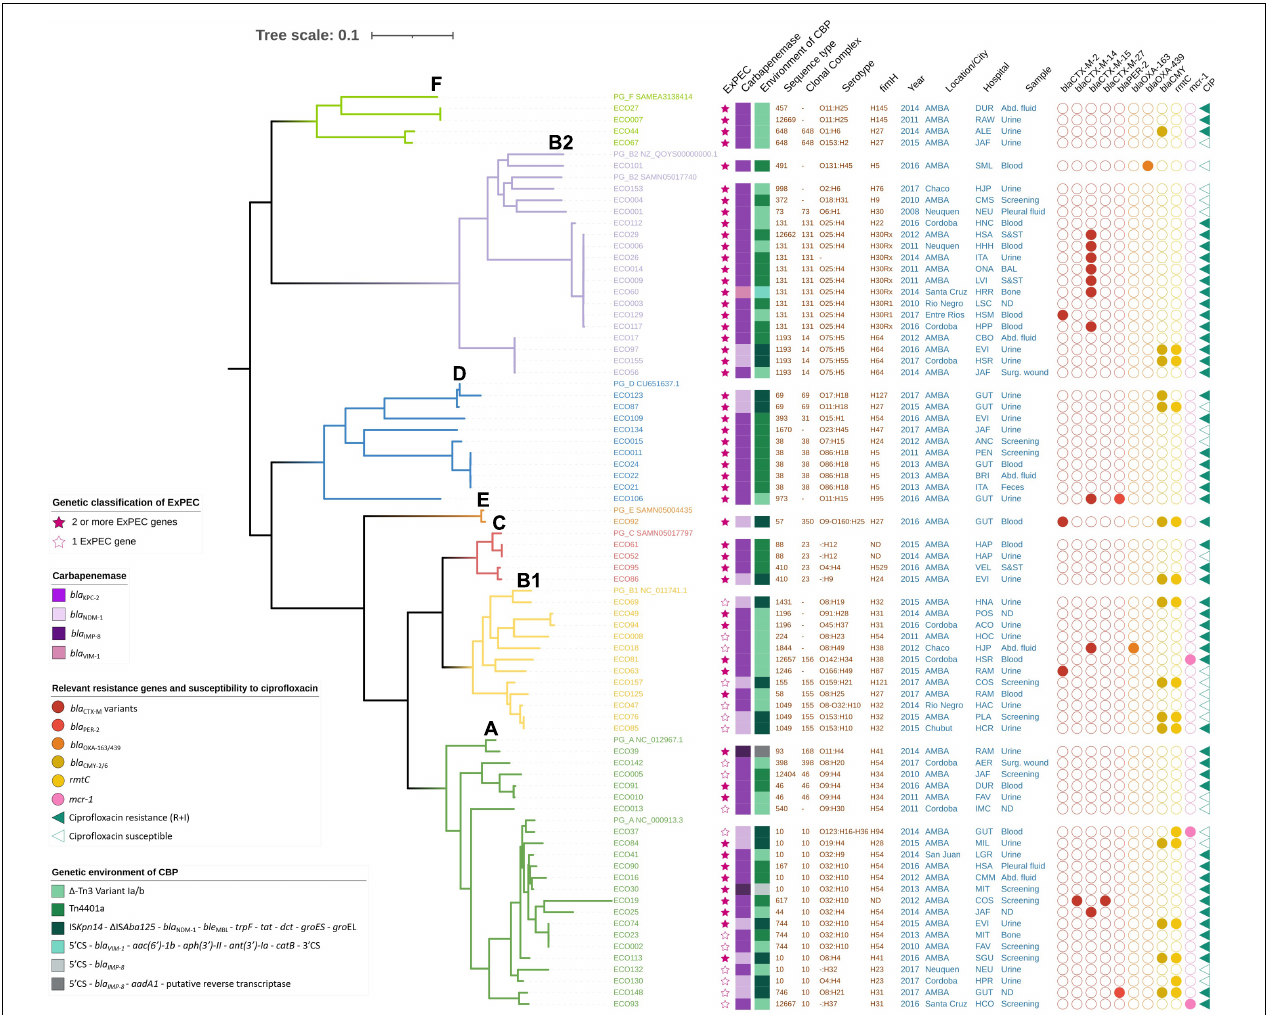
FIGURE 1 | Maximum likelihood tree of 71 Escherichia coli isolates belonging to phylogroups A, B1, B2, C, D, E, and F with metadata. The tree was drawn to scale, with branch lengths measured in numbers of substitutions per site. The dataset contained 1,061 core genes and 68,434 SNPs. Abd., abdominal; CIP, ciprofloxacin; CBP,